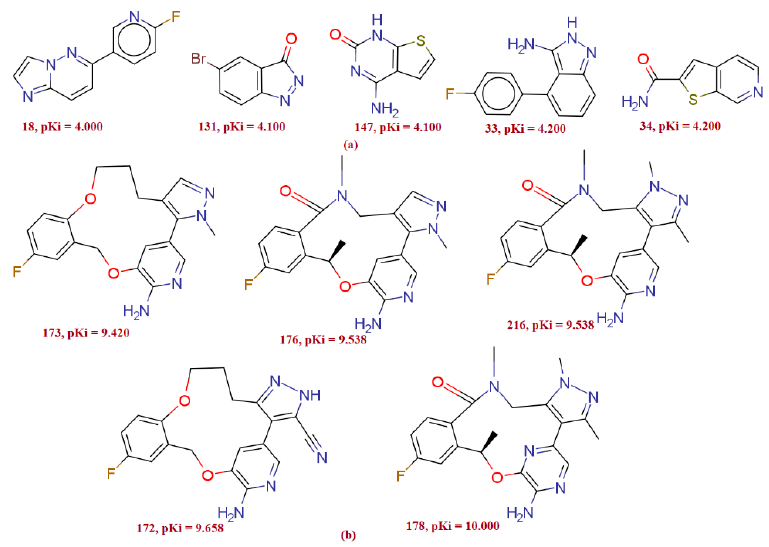
Figure 19. Variations in the Ki and chemical structure in the present dataset of ALK tyrosine kinase inhibitors: Five most active compounds ( b ), and five least active compounds ( a ) from the present series.